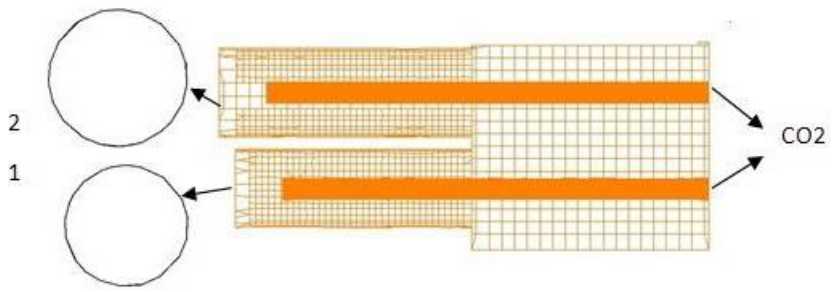
Figure 3. CO 2 pipes in the intake ports of the first cylinder, 1 and 2 are the inlet sections of intake port 1 and intake port 2, respectively.